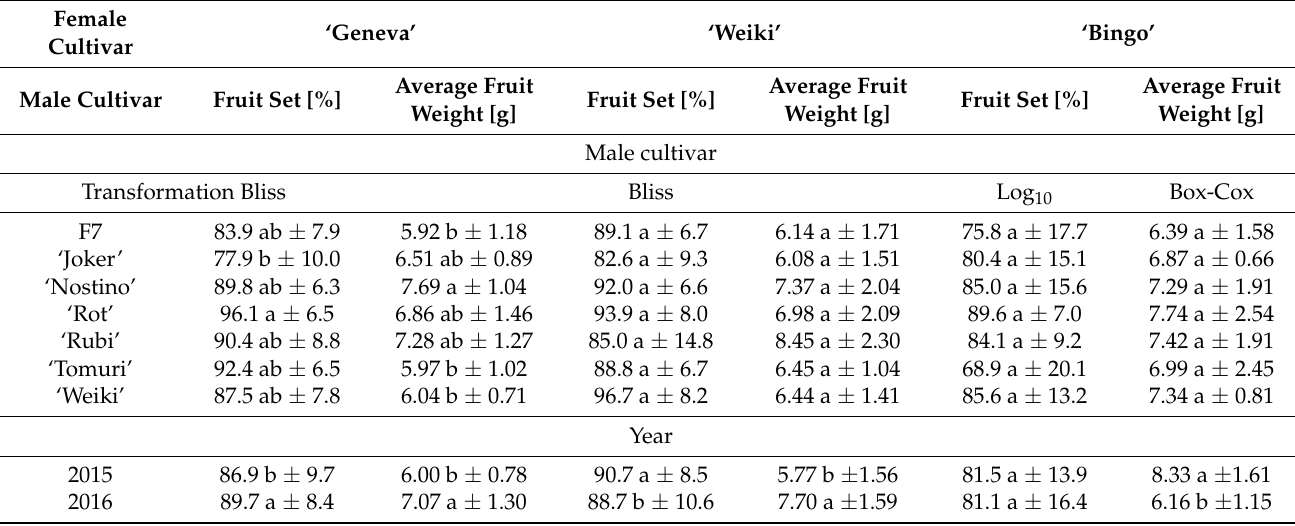
Table 4. Basic fruit parameters gained in different pollination combinations (data represent mean ± SD). Female ‘Geneva’ ‘Weiki’ ‘Bingo’ Cultivar Average Fruit Average Fruit Average Fruit Fruit Set [%] Fruit Set [%] Male Cultivar Fruit Set [%] Weight [g] Weight [g] Weight [g] Male cultivar